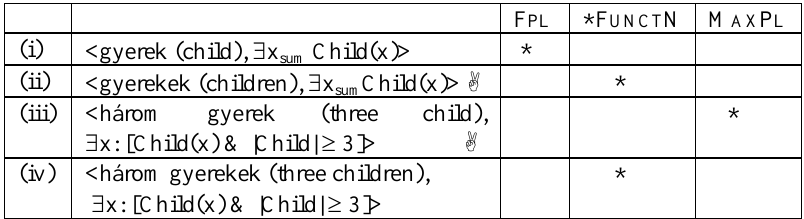
Tableau III: bare plurals and lack of plural agreement on the noun with plural cardinals